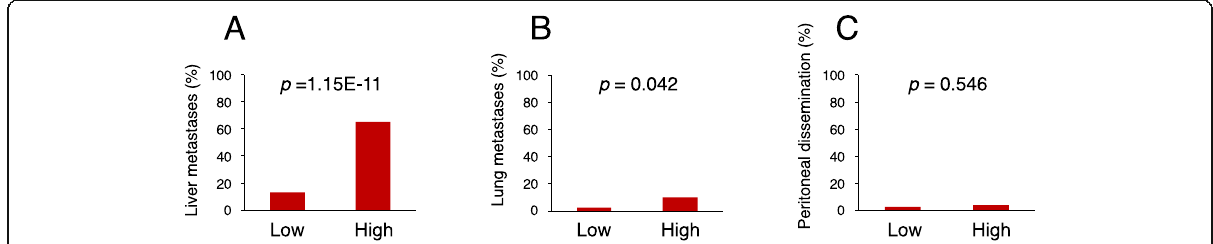
Fig. 4 Relationship between AMIGO2 expression in primary colorectal cancer and metastatic site. A high expression of AMIGO2 was significantly associated with liver metastases ( A ) and lung metastases ( B ), but not with peritoneal dissemination ( C ), as calculated using the X 2